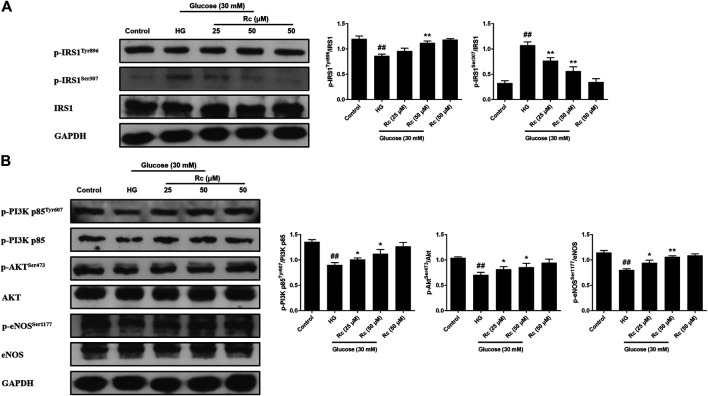
Effects of ginsenoside Rc on the insulin signaling pathway in HUVECs. The cells were treated with HG, with or without ginsenoside Rc (25 and 50 μM), for 24 h followed by insulin (100 nM) stimulation for 30 min. (A) Western blot analysis for p-IRS1Tyr896 and p-IRS1ser307. (B) Western blot analysis for p-PI3K p85Tyr607, p-AktSer473, and p-eNOSSer1177. Data were expressed as mean ± SD from three independent experiments. ##
p < 0.01 compared with control and *
p < 0.05 and **
p < 0.01 compared with HG.